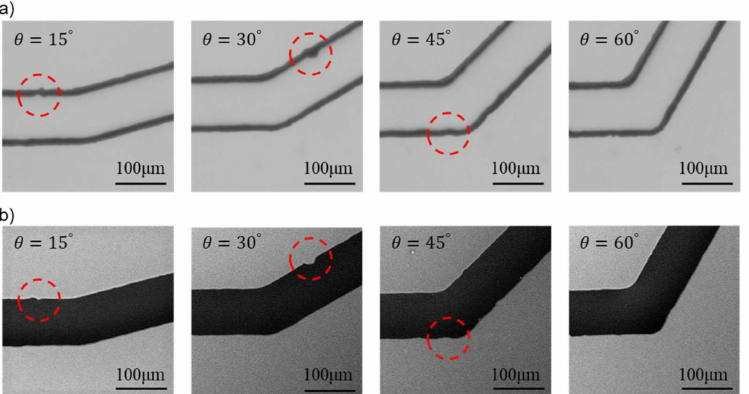
Figure 8. Scaled and aligned images from both microscopes with highlights on structural features. ( a ) Images from OM. ( b ) Images from